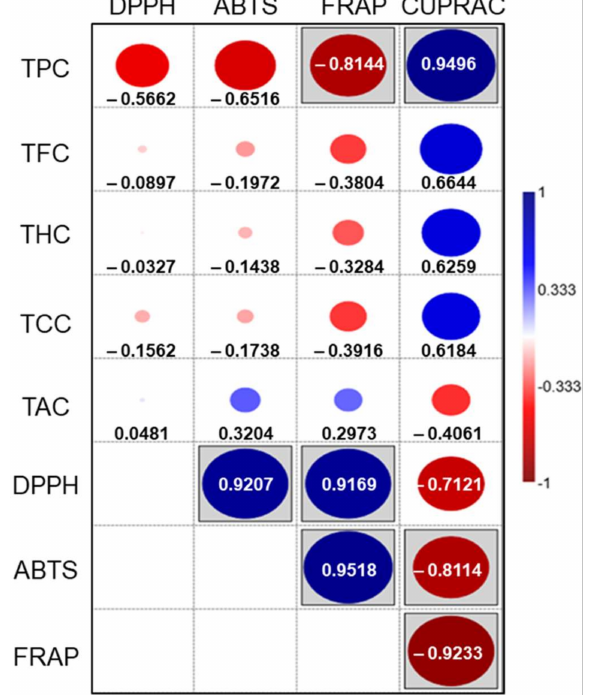
Figure 3. Pearson’s correlation between secondary metabolites and antioxidant capacities. The blue color represents positive correlations. The red color represents negative correlations. Boxed figures are statistically significant correlations ( p < 0.05). The circle diameter is proportional to the Pearson’s correlation coefficient (r), specified in each case with the number.